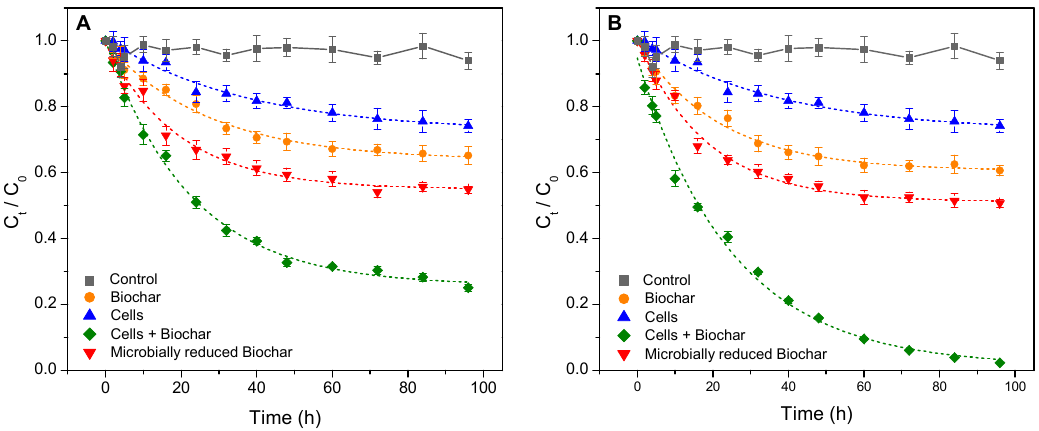
Figure 2. OG (Orange G) removal curves in different treatment systems. Biochars in ( A ) and ( B ) were prepared using peanut stalks from the plot without Fe addition and from the plot with Fe addition, respectively. The dashed lines show nonlinear least-squares regression fits to a first-order rate law. Aniline as a possible reduction product of Orange G was not detected in the suspension in the presence of BCNF or BCWF. This result indicated that BCNF and BCWF possibly functioned as an adsorbent in part removing the Orange G in the solution in the presence of biochar alone. The specific surface area, pore structure, particle size, surface functional groups, and pH of the biochars are the main physicochemical parameters that govern their abilities to adsorb organic pollutants [19]. BCNF and BCWF possessed the same properties in these parameters (Table 2), which may be responsible for the result that these two biochars did not exert significant difference in the adsorbing removal rate of Orange G in the solution (Figure 3A).